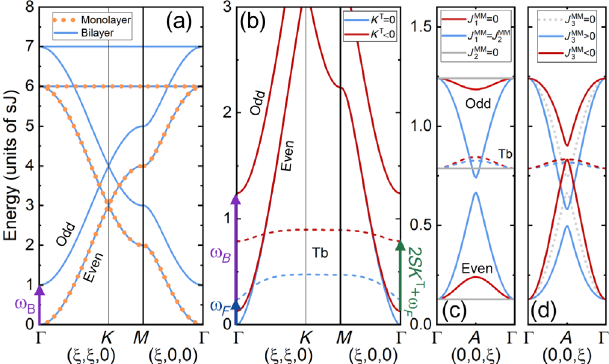
FIG. 2. (a) Monolayer kagome spin-wave dispersion with energy in units of s j J j (orange dots) and Mn-Mn bilayer dispersion with J MM 2 ¼ 0 . 5 j J j (blue lines). The latter shows the bilayer splitting of odd and even modes by ω B ¼ 2 s j J MM 2 j . (b) Low-energy dispersion when Mn bilayers are coupled through Tb with S ¼ 3 s and J MT ¼ − 0 . 04 J (blue lines). The odd bilayer mode and Tb mode (dashed line) are shifted by the ferrimagnetic exchange field, ω F ¼ 2 ð 6 s − S Þ J MT , as shown. Red lines include uniaxial Tb single-ion anisotropy with K T ¼ 0 . 07 J and K M ¼ 0 that introduces a spin gap in the even mode ( Δ ) and increases the Tb mode spin gap ( Δ ). (c) Interlayer dispersion of low-energy Tb branches with identical bilayer splitting, J MM 1 þ J MM 2 ¼ 0 . 5 J for cases where J MM 1 ¼ J MM 2 (blue lines), J MM 1 ¼ 0 (red lines), and J MM ¼ 0 (gray lines). (d) Interlayer dispersion of low-energy 2 branches when J MM 1 ¼ J MM 2 and the coupling between Mn layers in adjacent unit cells, J MM 3 is either ferromagnetic (red lines), antiferromagnetic (blue lines), or zero (gray dashed